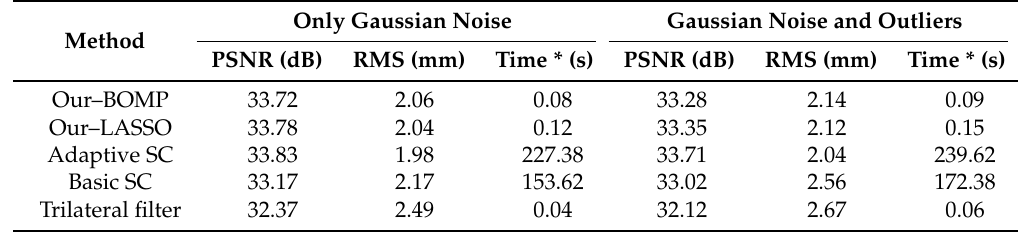
Table 3. Denoising results on the synthesized data. RMS: root mean square; SC: sparse coding.